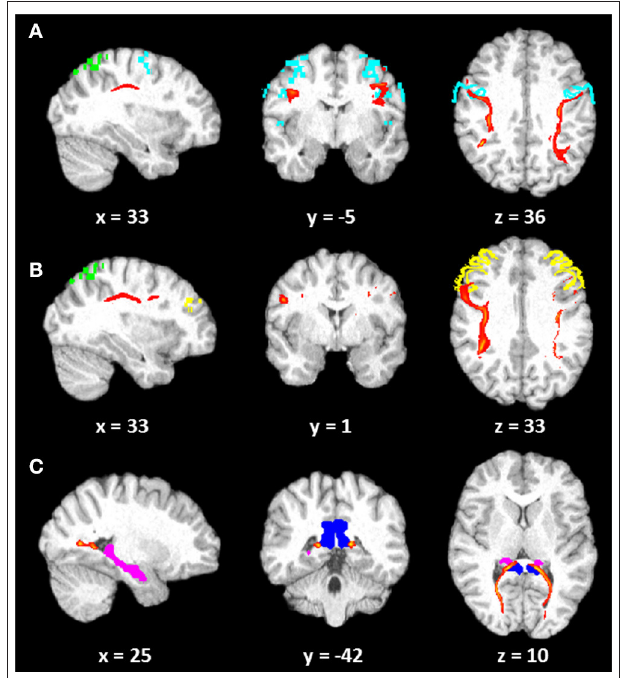
FIGURE 1 | Diffusion tensor imaging (DTI) images. Tracts (red) reconstructed (10% threshold) in LISA: (A) connection between Brodmann area (BA) 7 (green) and BA6 (light blue); (B) connection between BA7 (green) and BA9 (yellow); (C) connection between the posterior cingulum (blue) and the hippocampus (pink). Coordinates are in Montreal Neurological Institute (MNI)